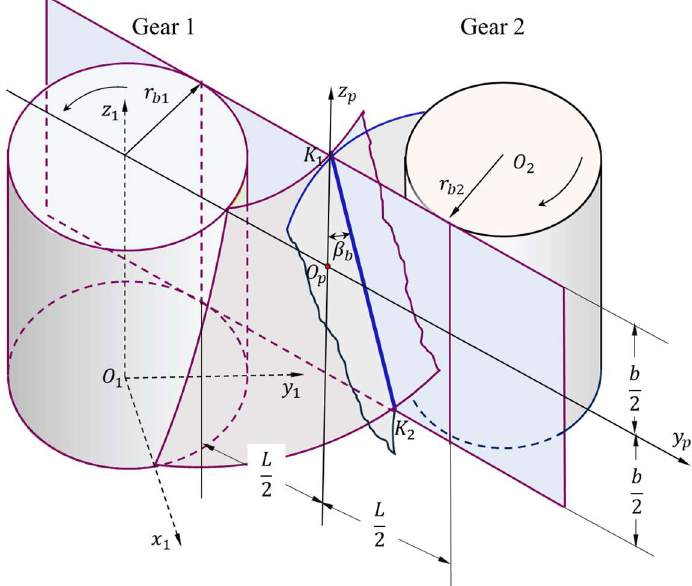
Figure 2. Gear coordinate system and meshing plane coordinate system. When the gears are meshed, a coordinate system is established in the meshing area. The y p axis and the z p axis are respectively along the tooth profile rolling direction and the facewidth direction. Its origin O p is located in the center of the selected analysis area with the dimension b in the facewidth direction and the dimension L in the rolling direction of the tooth profile. K 1 K 2 is the contact line during meshing, and its angle with the gear axis is β b